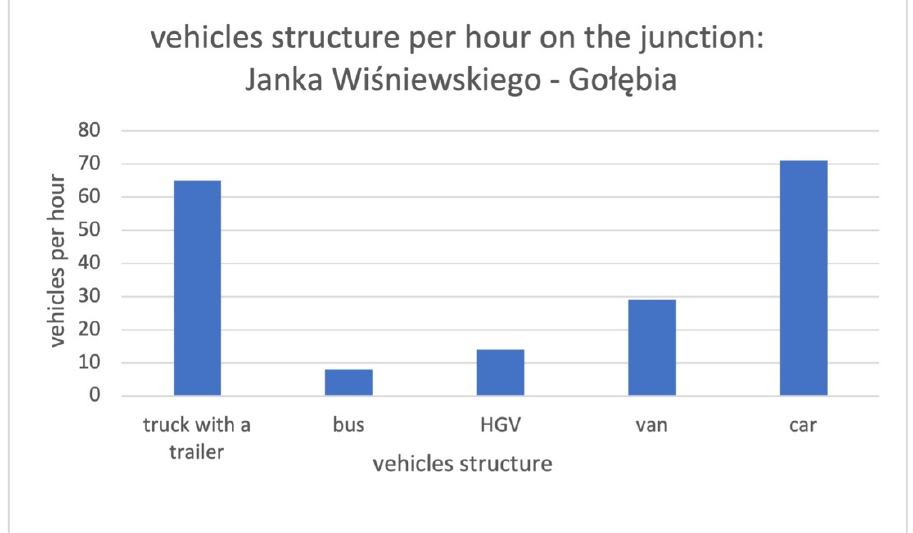
Figure 2. Structure of the vehicles on junction Janka Wi ś niewskiego—Go łę bia, (P—pedestrian, T—trams, M/R—motorbike/bike, C/P—a truck with a trailer, A—bus, C—HGV, F—van, O—car [veh/h]).